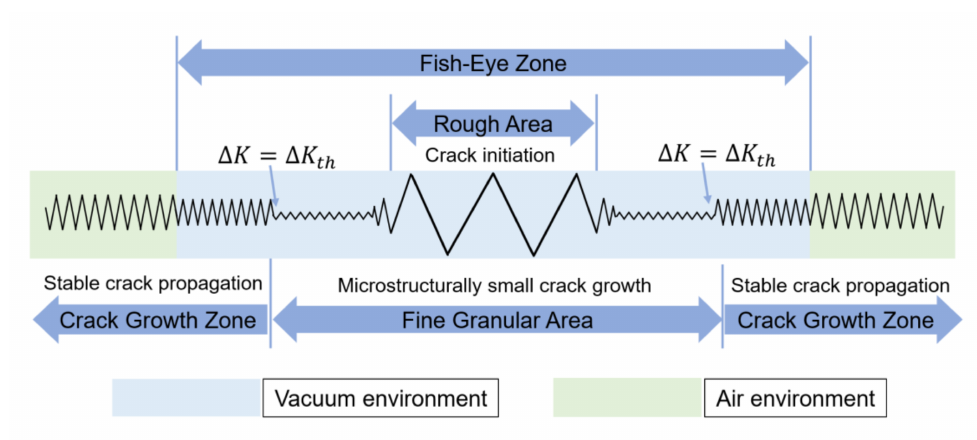
Figure 13. Inconel 625 crack propagation model (internal